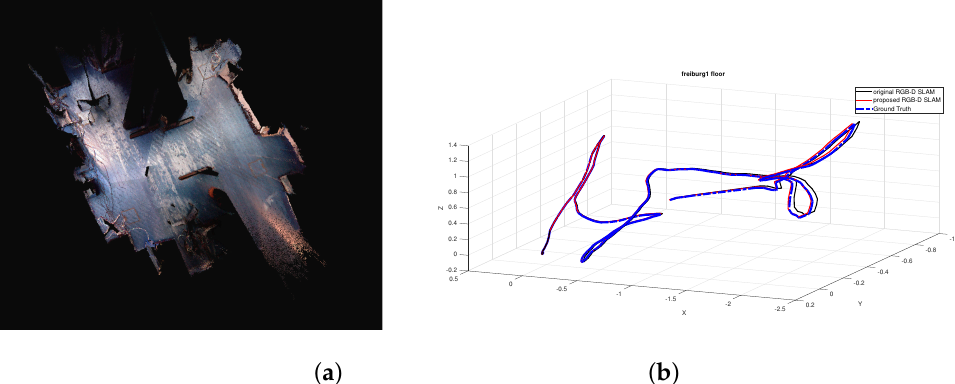
Figure 4. Experimental results of the proposed RGB-D SLAM with sequence fr1/floor. ( a ) Mapping results in the form of volumetric 3D model. ( b ) Estimated trajectories.